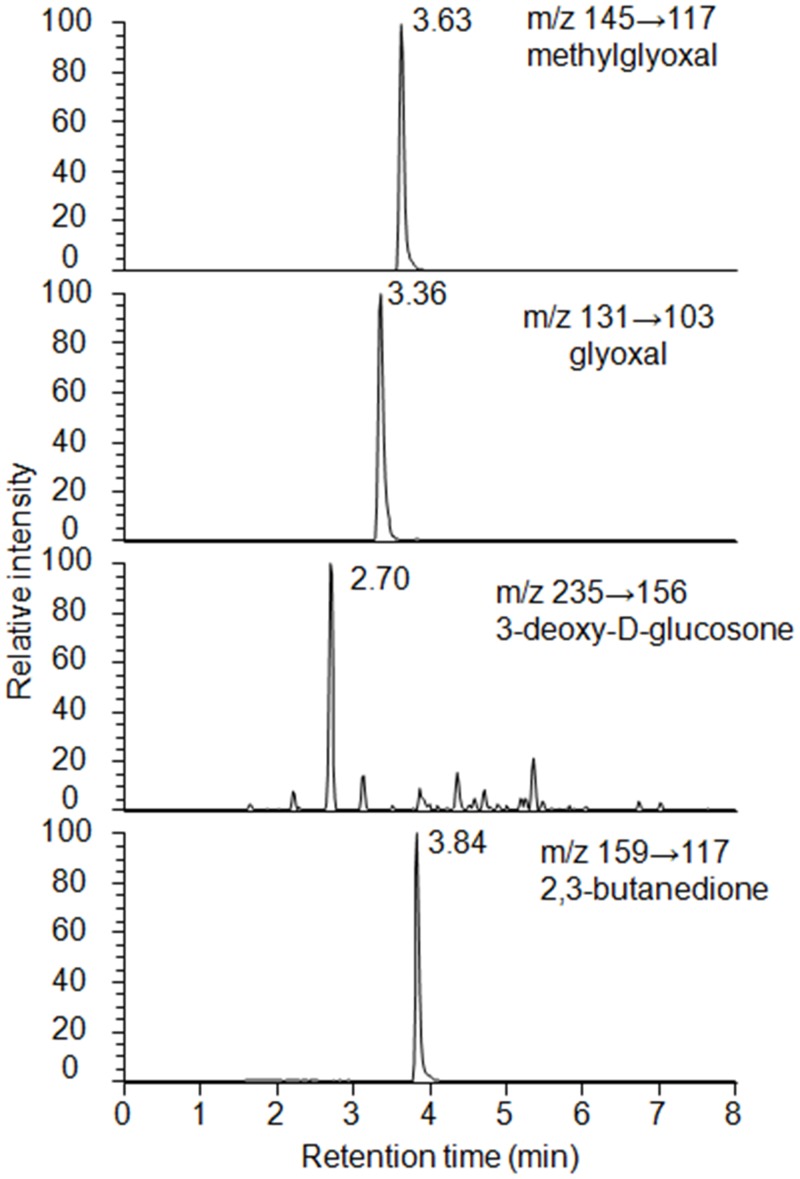
Chromatograms of derived methylglyoxal, glyoxal, 3-deoxy-D-glucosone and 2,3-butanedione.The concentration of each substance tested was 6.25 pmol. The ion transition of the derived methylglyoxal, glyoxal, 3-deoxy-D-glucosone and 2,3-butanedione was m/z 145→117, m/z 131→103, m/z 235→156, and m/z 159→117, respectively.